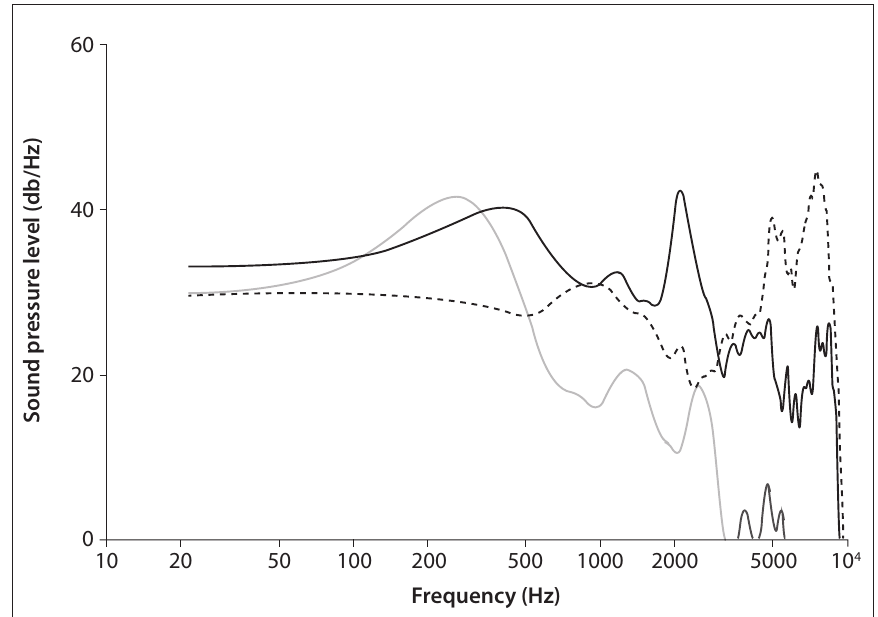
Fig. 1. Frequency spectrum for /m/ /g/ /t/ tokens